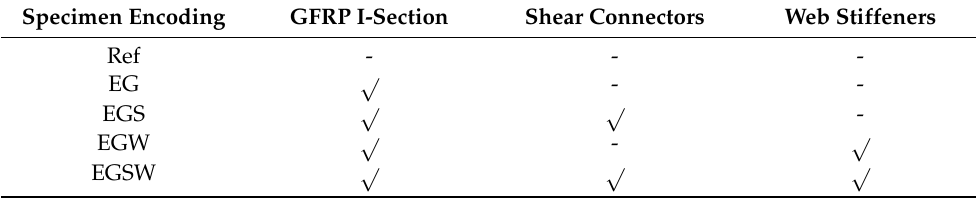
Table 1. The test matrix for the conducted experimental